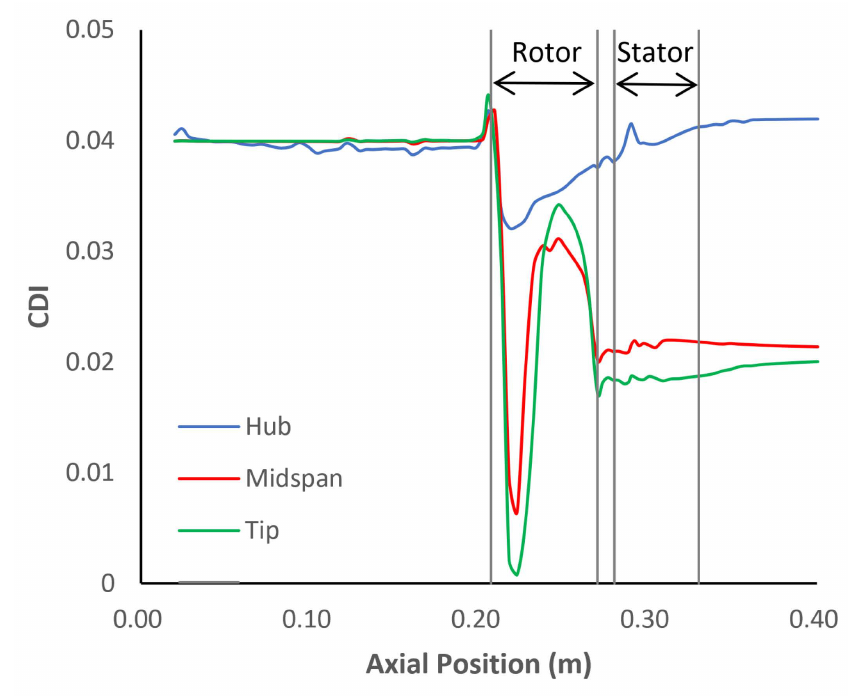
Figure 20. Total pressure distortion transmission characteristics along axial position at different blade heights.